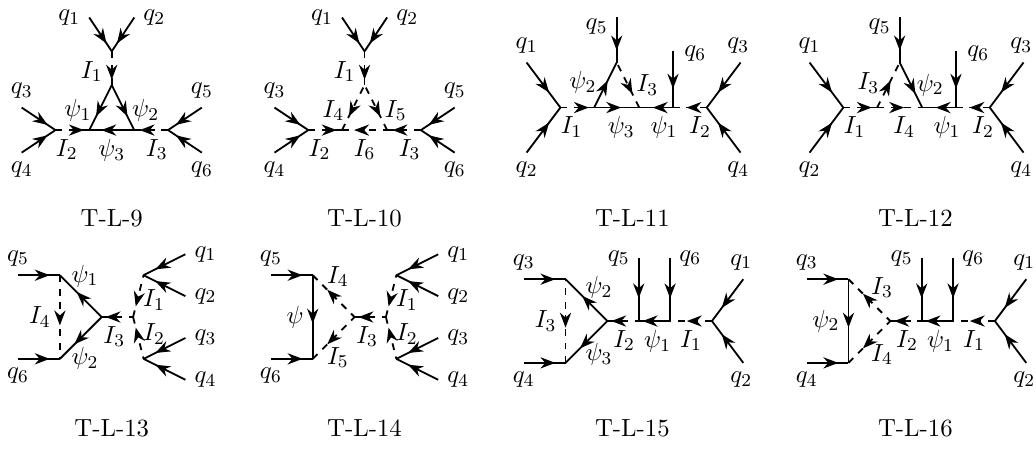
Figure 3 . The non-genuine diagrams of neutron-antineutron oscillation operator at one-loop level. the more possible